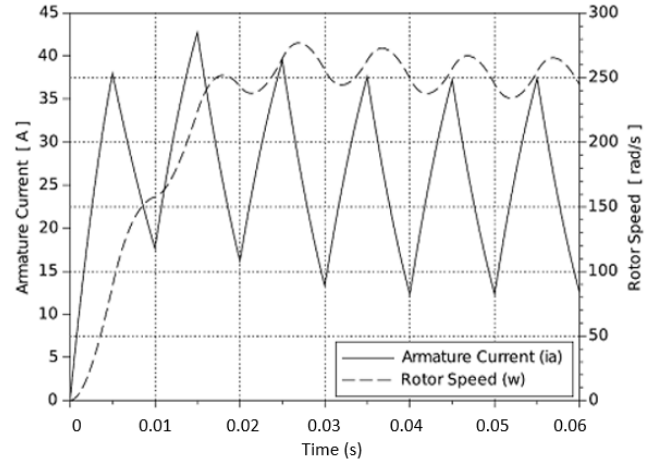
Figure 12. Simulation (Scilab) under no-load conditions, with a PMW supply voltage of amplitude equal to 100 V and a duty cycle of 50%. The dependent variable is ω ( t ) .